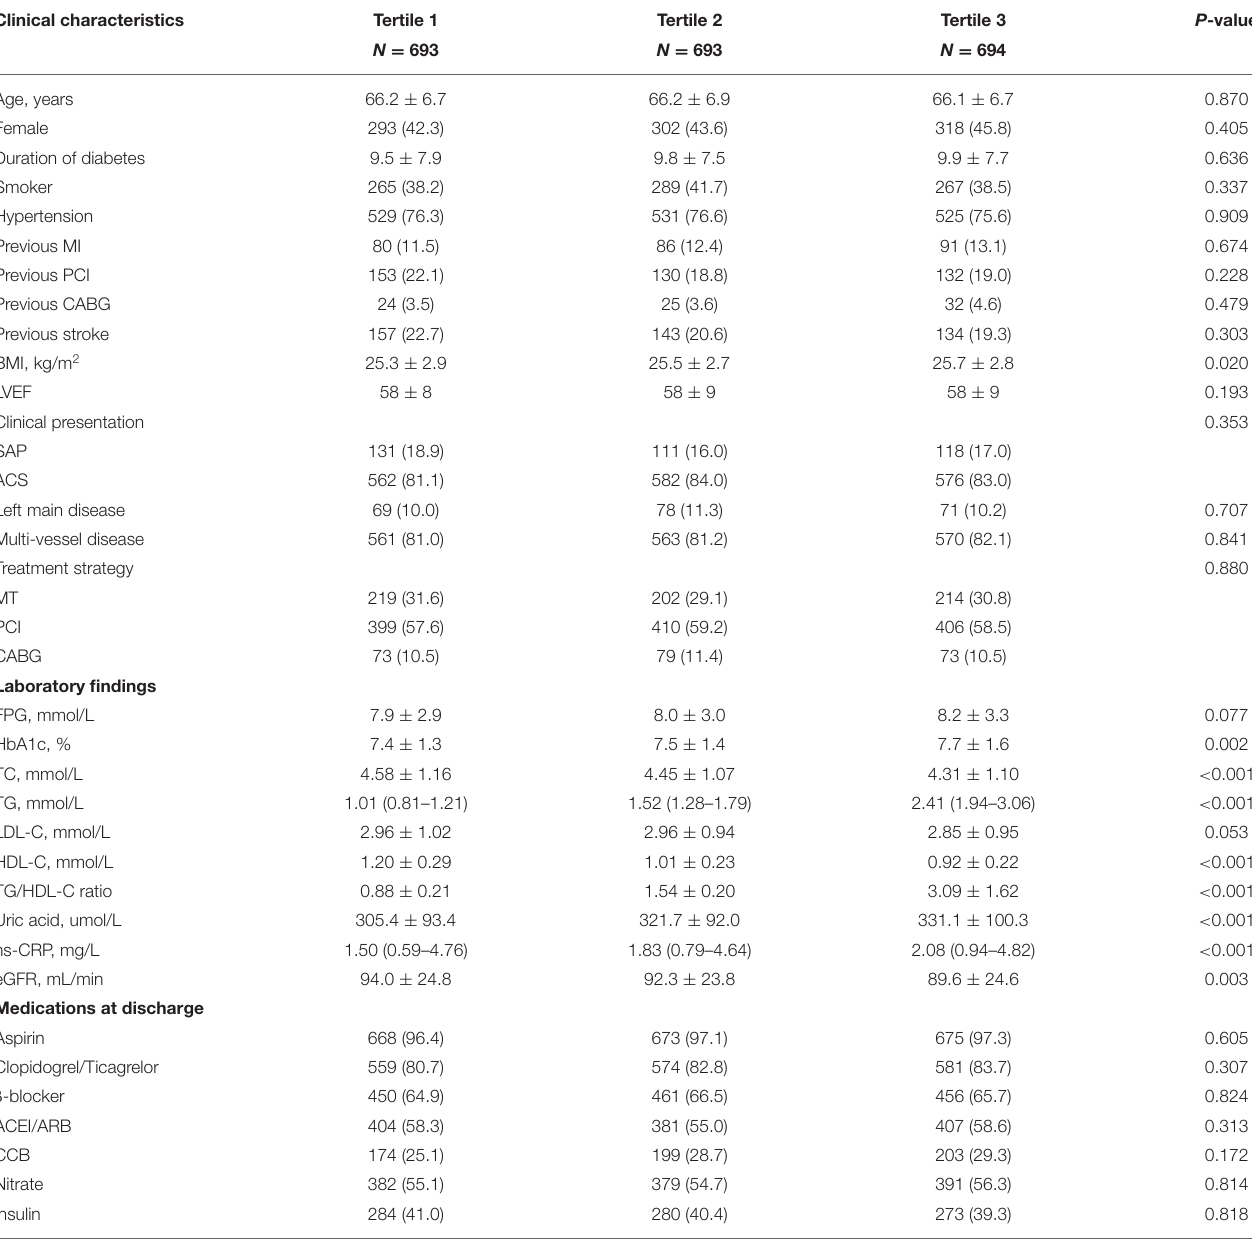
TABLE 1 | Baseline characteristics of included